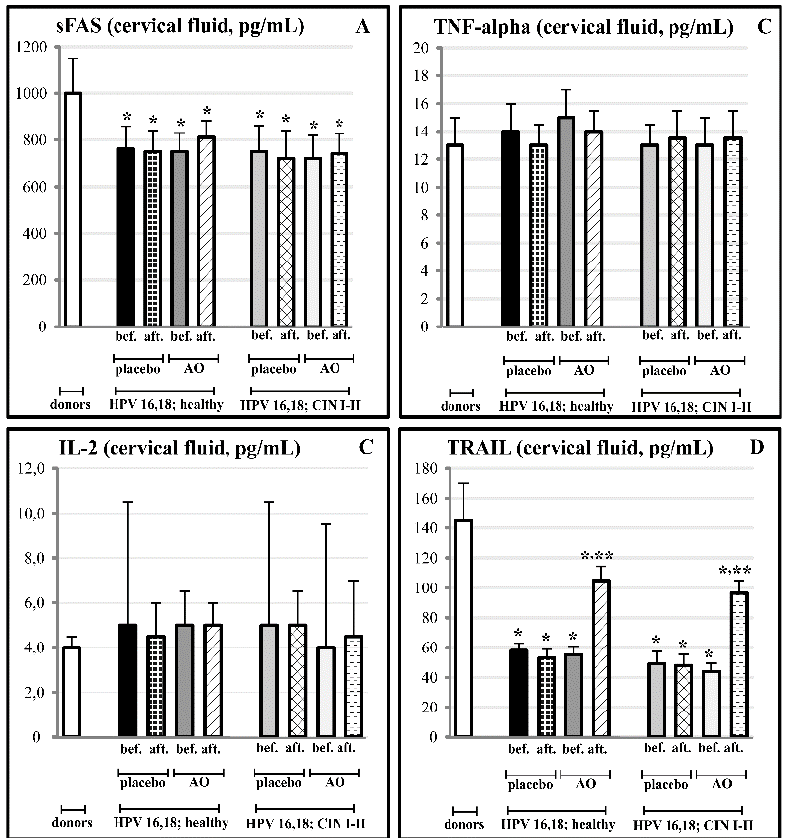
Figure 7. Effects of fermented mangosteen (FM) supplementation on cervical fluid content of the apoptosis ligands ( A —sFAS; B —TNF-alpha; C —IL-2; D —TRAIL) in groups of practically healthy HPV16- and HPV18-infected females (n = 152) and in groups of HPV16- and HPV18-infected females with pre-cancerous cervical lesions (CIN I and CIN II) (n = 98). * p < 0.05 vs. donors; ** p < 0.05 vs. before